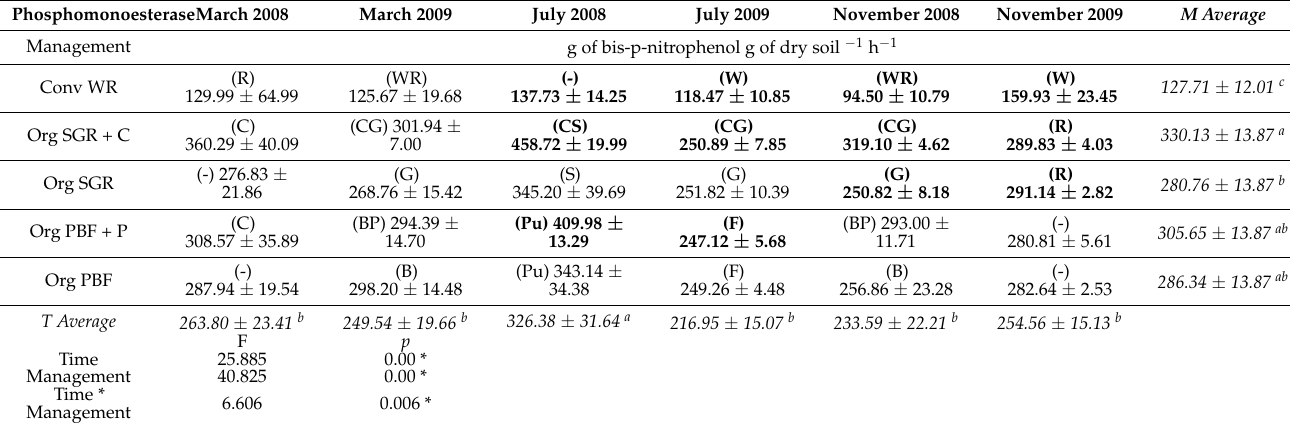
Table 10. Phosphomonoesterase enzymatic activity in soil.